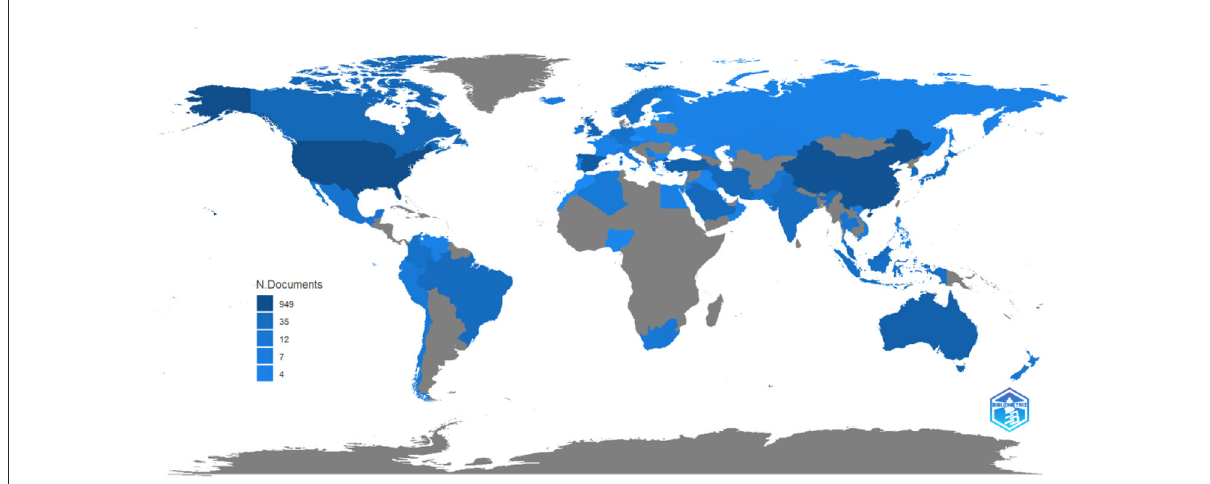
FIGURE4 Main countries which published on flipped classroom. Source: Bibliometrix in R.